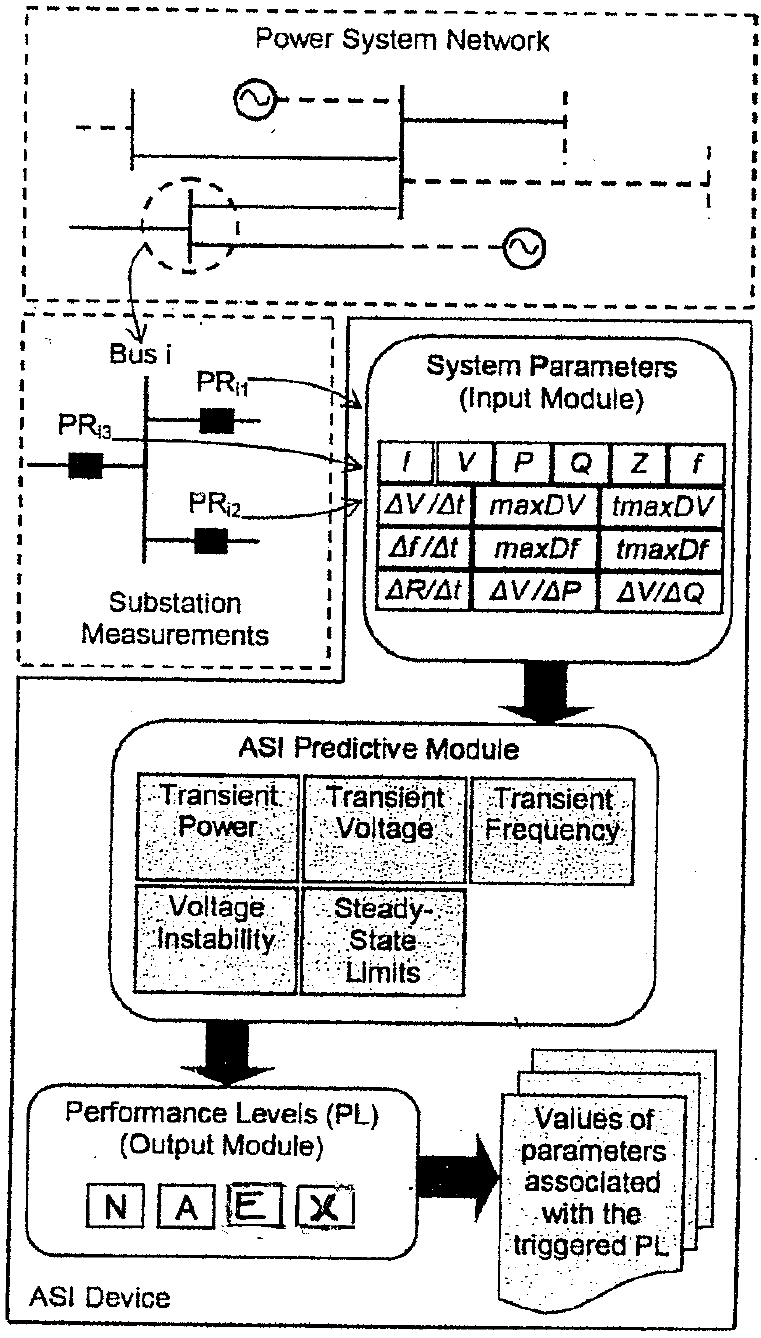
Figure 1. Concept of the ASI. (N = Normal, A = Alert, E = Emergency condition, X = eXtreme condition. There would be a local display of Levels and at the System Office there would simply be the four lights plus a curser click to bring up only the important parameters on the main